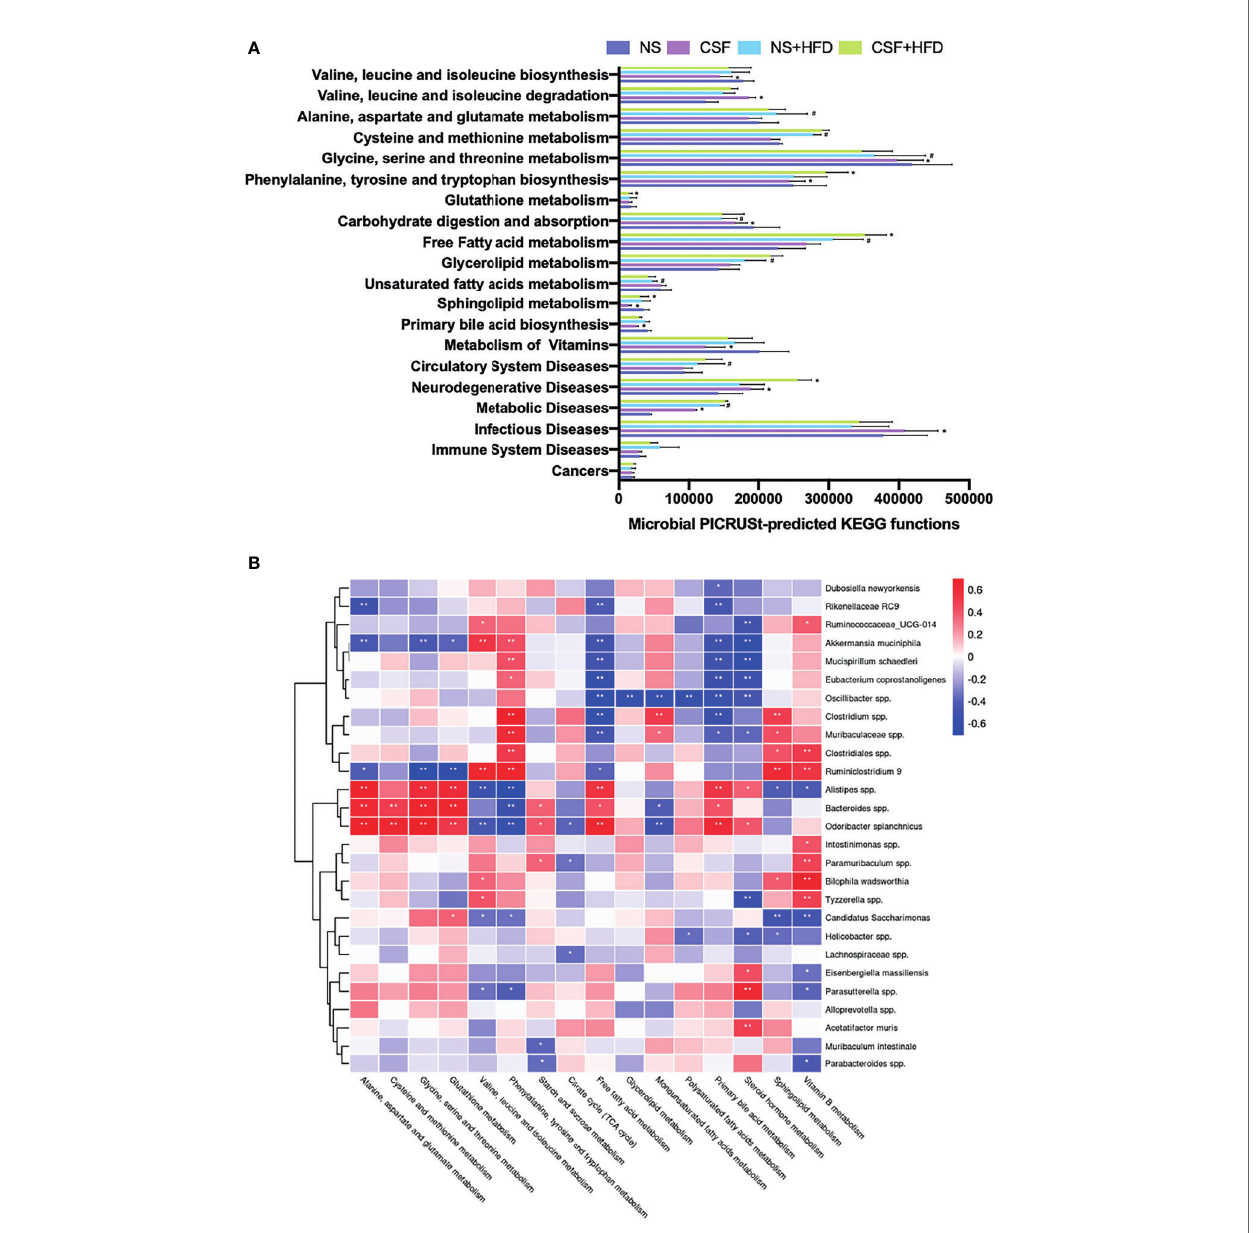
FIGURE 9 | CSF-related fecal microbiota functional changes and correlations between the host metabolome and fecal microbiome. (A) Microbial PICRUSt ‐ predicted KEGG functions relevant to metabolism and diseases. Data are expressed as mean ± SEM. Group differences were assessed by using the Mann ‐ Whitney U test. *P < 0.05 when comparing NS vs CSF, or NS+HFD vs CSF+HFD. # P < 0.05 when comparing NM vs NM+HFD. (B) Spearman correlations of the relative abundance of fecal microbial genus or species and the abundance of metabolite pathways in host serum (n = 36). The r values are represented by gradient colors, with red cells indicating positive correlations and blue cells indicating negative correlations. *P < 0.05, and **P <